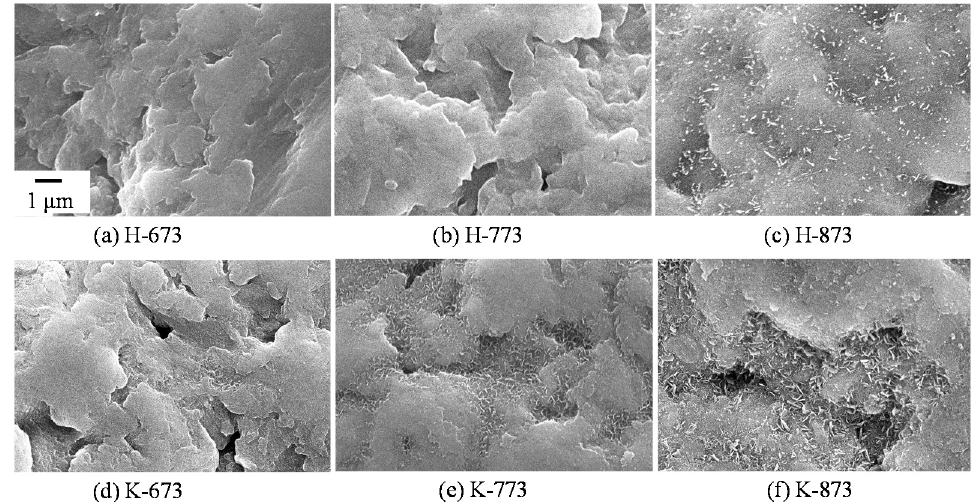
Figure 56. SEM micrographs of surfaces microstructure of the K- x and H- y samples.